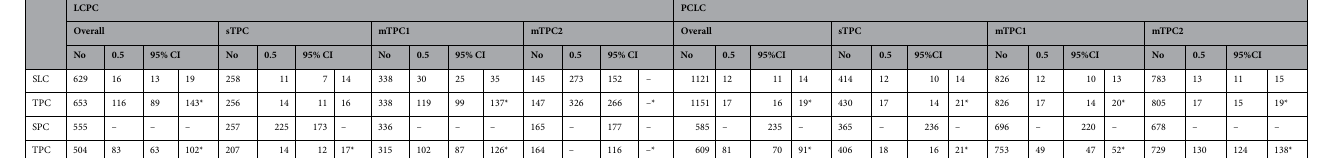
Table 2. Overall-survival of LCBC, BCLC and matched single lung/bladder cancer. Overall survival time of all LCBC and the categorized group mTPC1 were longer than matched single lung cancer, whereas overall survival time of all LCBC, the categorized group sTPC and mTPC1 were shorter than that of corresponding single bladder cancer. For BCLC, overall survival time of all and categorized groups was generally not different from that of the matched single lung primary, whereas overall survival time of all and categorized group sTPC were shorter than that of matched single bladder cancer. SLC single lung cancer; SBC single bladder cancer; LCBC lung cancer with subsequent bladder cancer; BCLC lung cancer with previous bladder cancer; TPC two primary cancer; ‘-’not reached. ‘*’indicated p value was < 0.05.